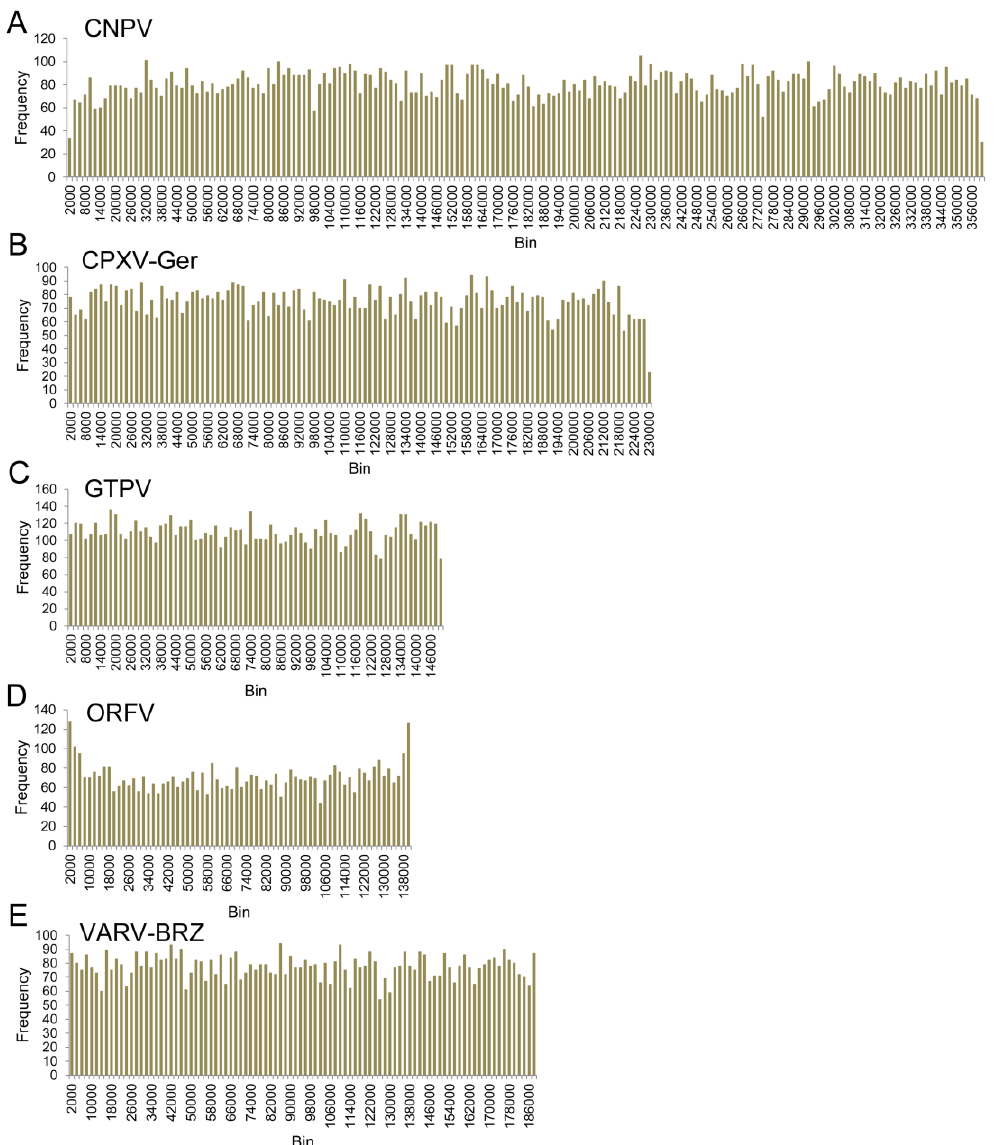
Figure 5. Distribution of microsatellites across genomes. The number of microsatellites is shown for bins of 2000 bp. The number of bins reflects the length of each genome. The isolates shown are ( a ) CNPV; ( b ) CPXV-Ger; ( c ) GTPV; ( d ) ORFV; and ( e )